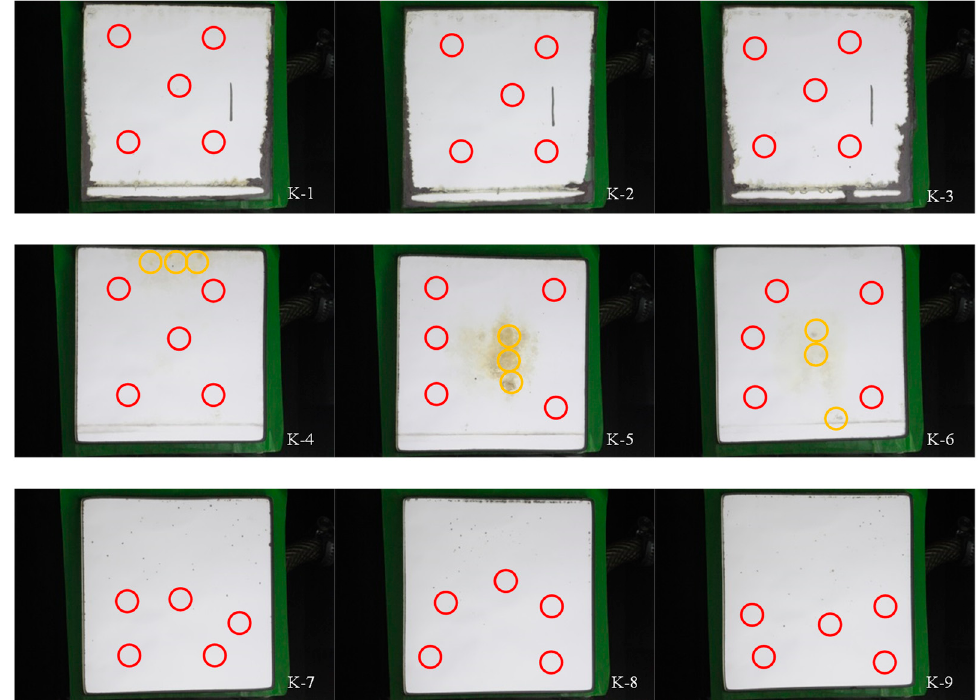
Figure 10. Images of the corroded reflector samples tested in the Kesternich test, with the measurement spots marked with red circles (non-corroded area) or yellow circles (corroded area).